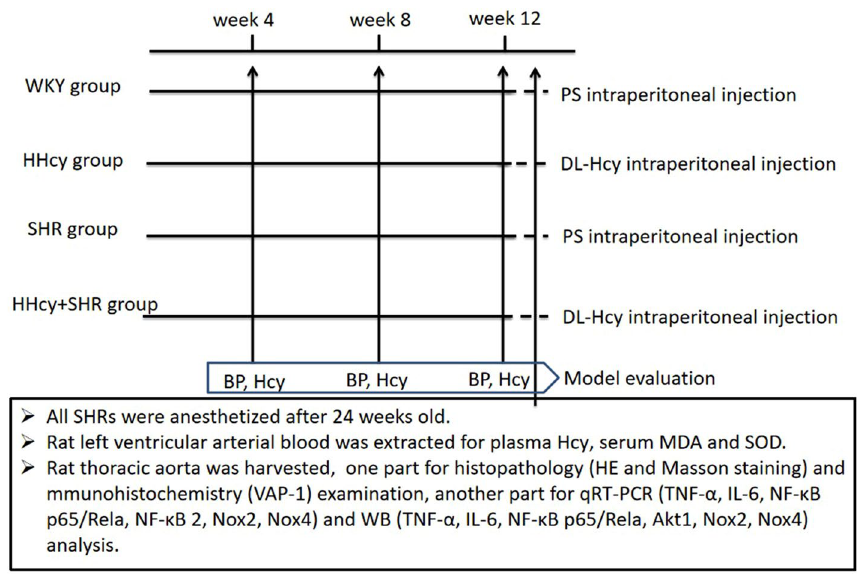
Figure 1. Flow chart of experiment. WKY Wistar-Kyoto, HHcy hyperhomocysteinemia, SHR spontaneously hypertensive rat, Hcy homocysteine, MDA malondialdehyde, SOD superoxide dismutase, BP blood pressure, PS physiological saline, HE hematoxylin and eosin, VAP - 1 vascular adhesion protein-1, TNF - α tumor necrosis factor-alpha, IL-6 interleukin-6, NF-κB nuclear factor-κ-gene binding, Nox nicotinamide adenine dinucleotide phosphate oxidase, Akt1 protein kinase